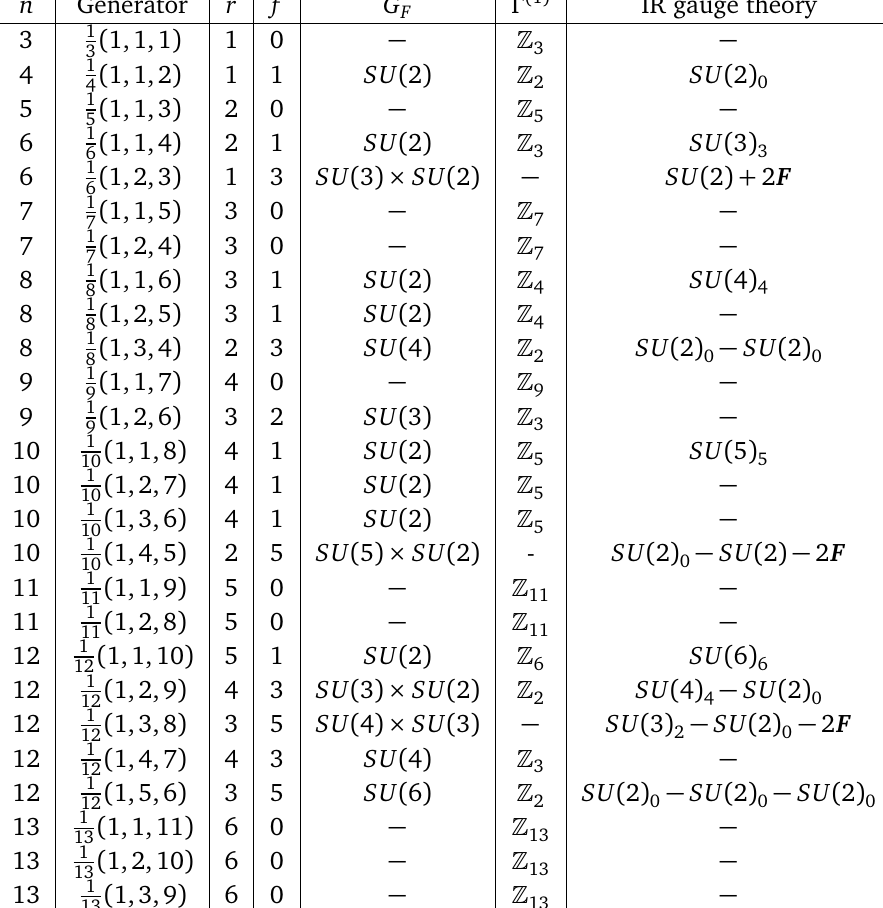
Table 5: List of (cid:67) 3 / (cid:90) with their generators, r , f , UV flavor symmetry G n symmetry Γ ( 1 ) and IR gauge theory descriptions of the corresponding 5d